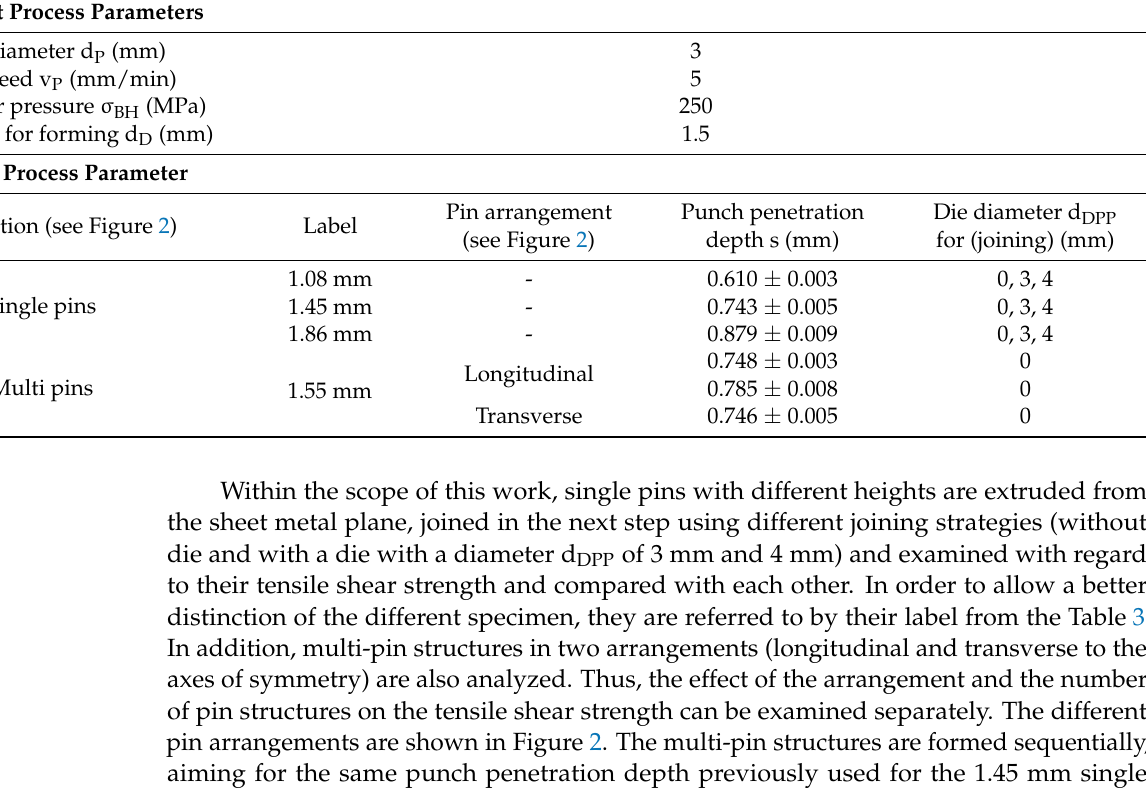
Figure 1. Process schematic for extruding pin structures from the sheet metal plane. Table 3. Relevant process parameters of the cold forming process for the pin structures. Cold Forming and Joining of Pin